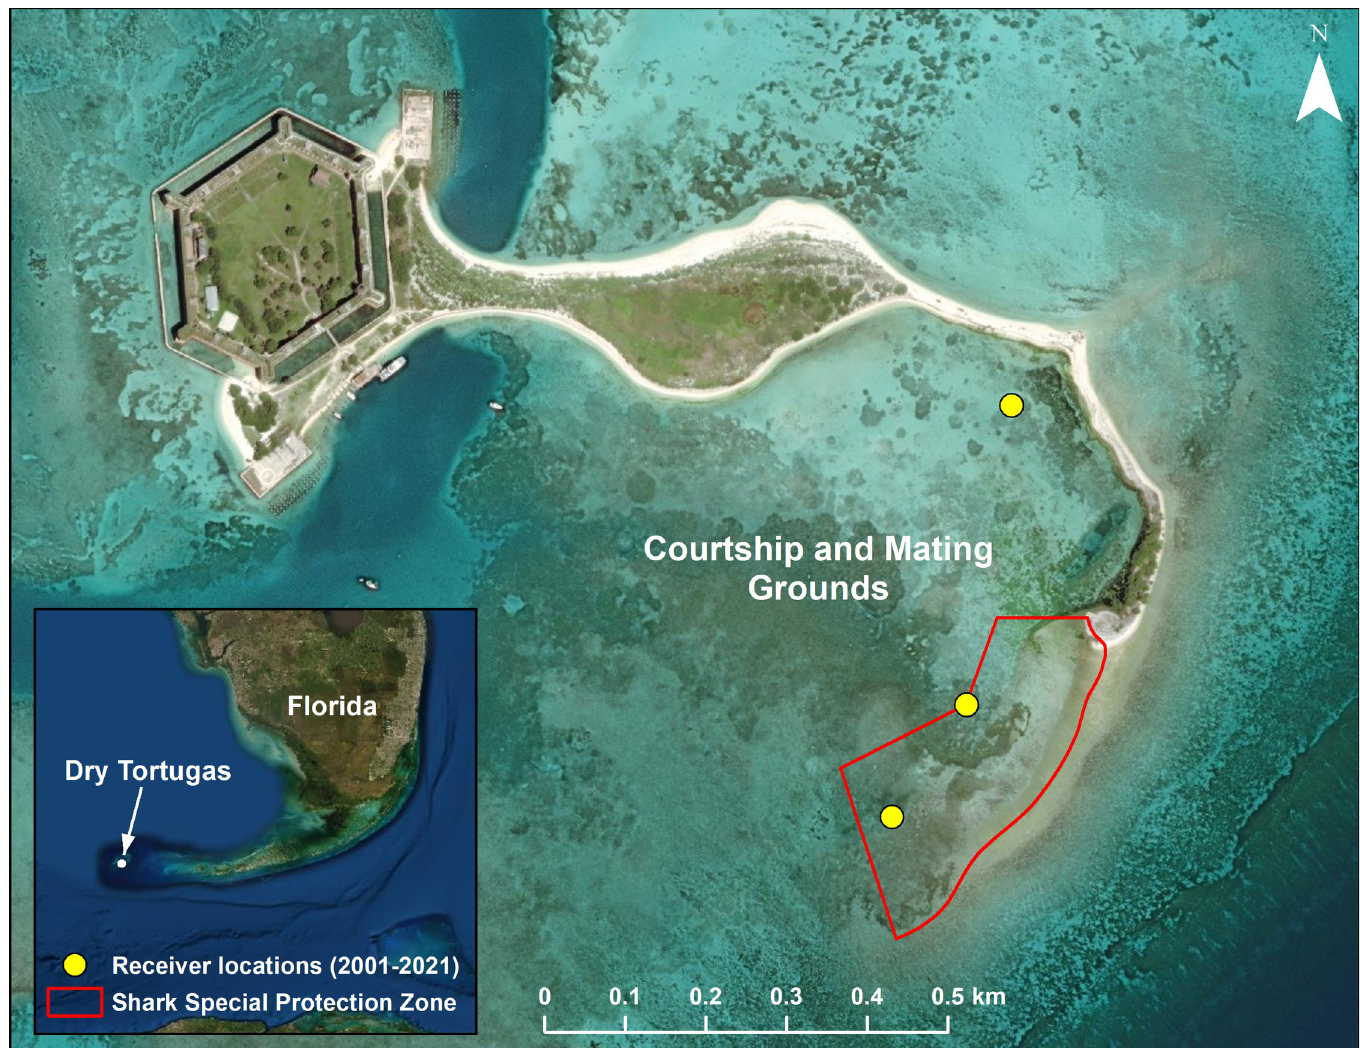
Fig 1. The Dry Tortugas courtship and mating ground with year-round acoustic receiver locations from 2001 to 2021. Receivers shown as yellow circles, the general area used by nurse sharks during the mating season (denoted with text), and the Shark Special Protection Zone (red outline) that has been closed to human activity during the mating season since 1998. Inset shows the location of Dry Tortugas relative to the Florida peninsula. The basemap (world imagery) image is the intellectual property of Esri and is used herein under license. Copyright © 2020 Esri and its licensors. All rights reserved. Basemap source: Esri, Maxar, Earthstar Geographics, and the GIS User